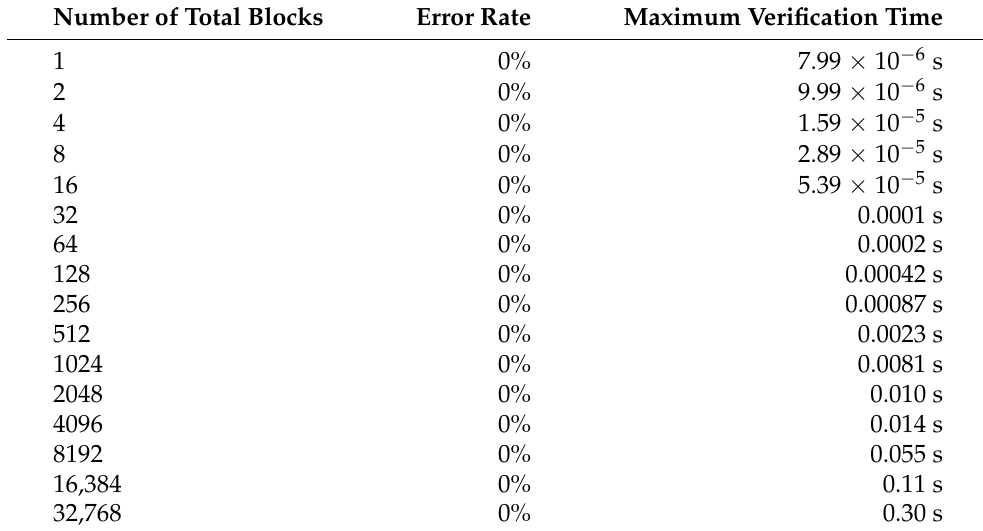
Table 6. Blockchain blocks results.